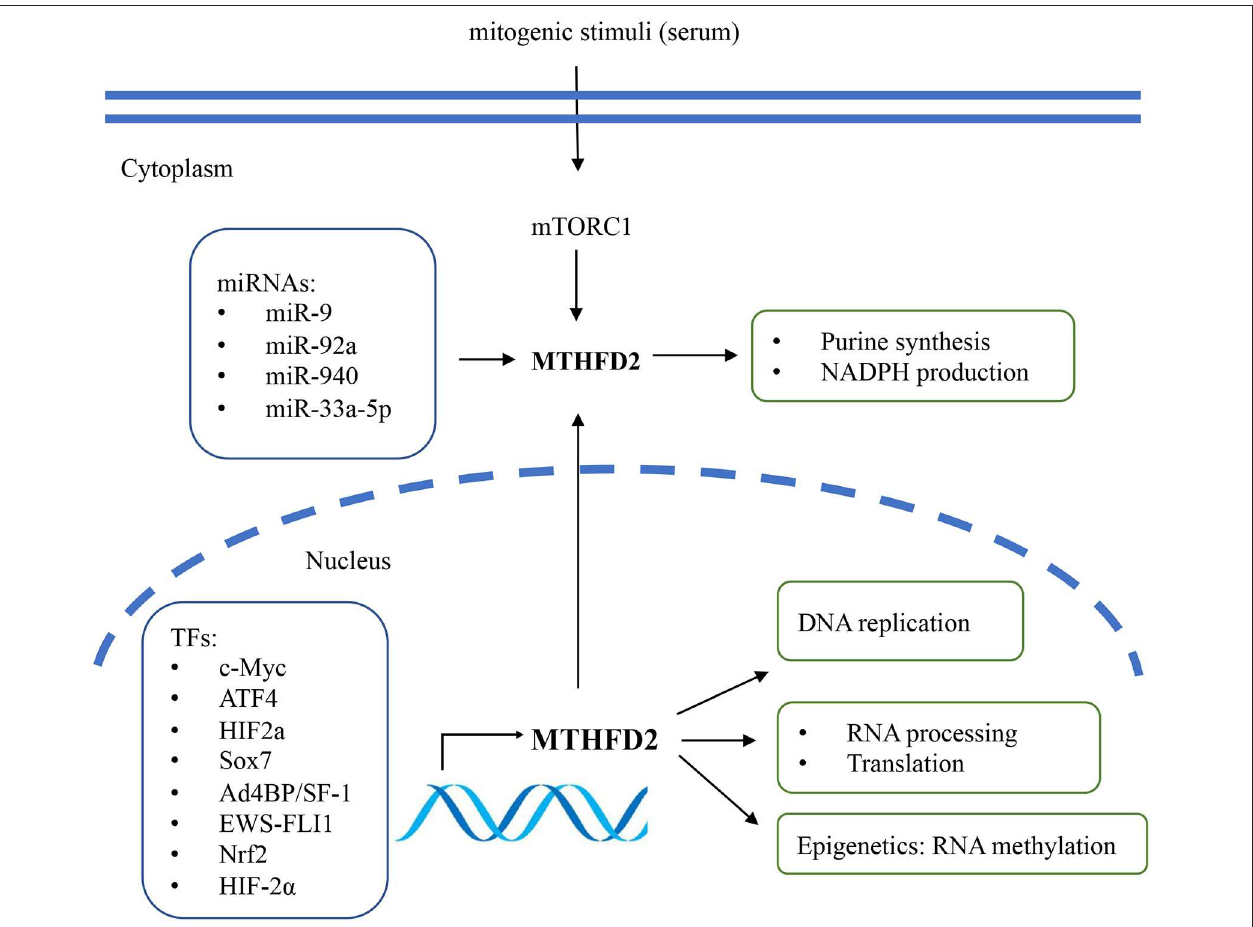
FIGURE 2 | The regulatory mechanisms and biological functions of MTHFD2 in cancer. The gene expression of MTHFD2 is transcriptionally regulated by various transcriptional factors and post-transcriptionally regulated by microRNAs. Extracellular stimuli may modulate MTHFD2 expression via mTORC1/ATF4 signaling pathway. The canonical role of MTHFD2 is converting one-carbon units for de novo purine synthesis. It may also involve in the production of redox equivalent (NADPH) for oxidative stress defense. In the nucleus, this enzyme may play a role in DNA replication, RNA processing and